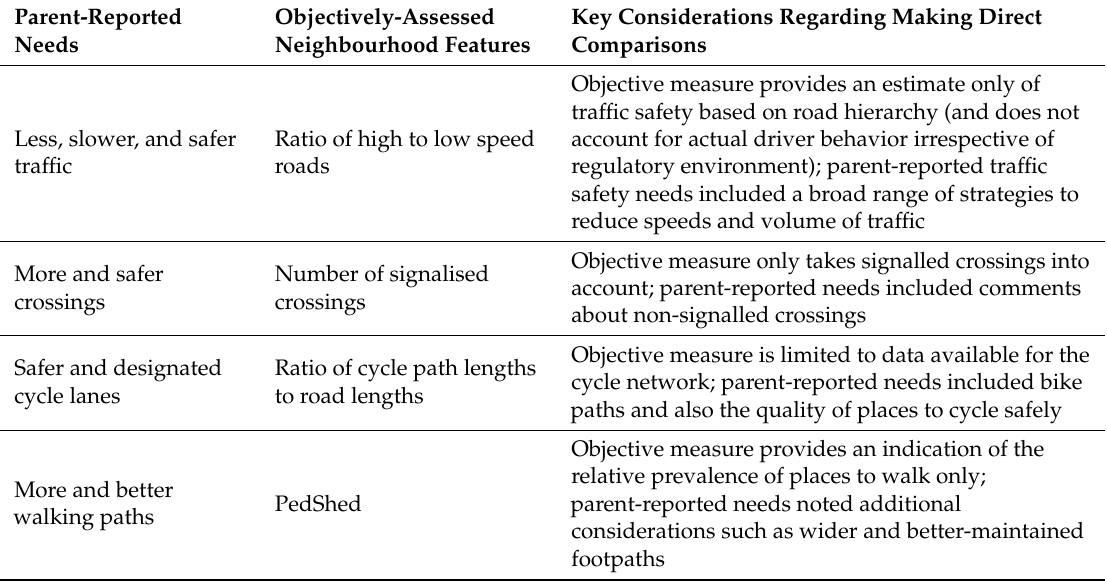
Parent reported need and corresponding objective measure of the neighbourhood built